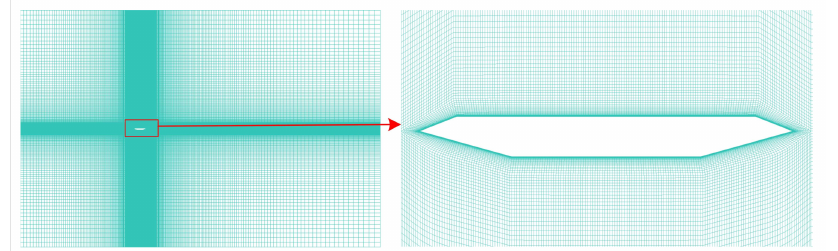
Figure 3. Meshing